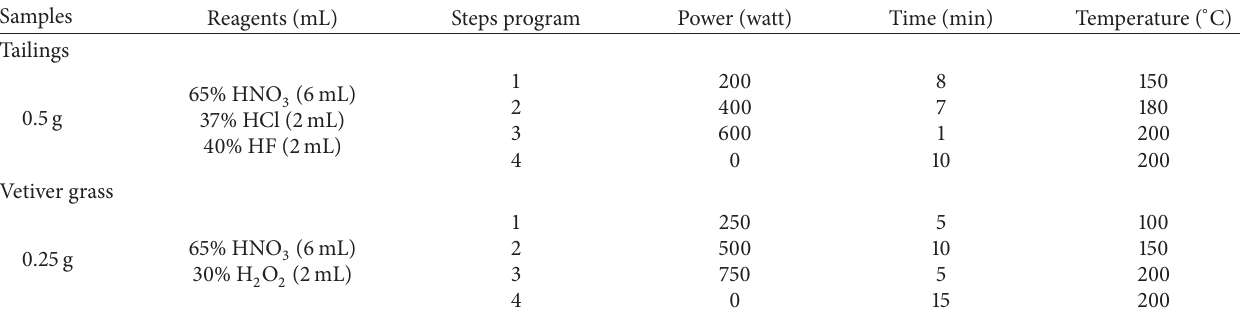
Table 1: The operating conditions for the microwave digestion